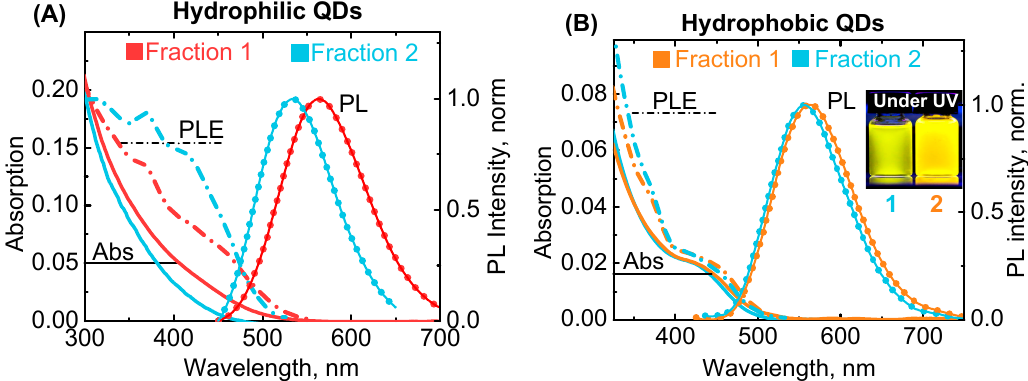
Figure 3. Photoluminescence and photoluminescence excitation spectra for two fractions of hydrophilic ( A ) and hydrophobic ( B ) AIS/ZnS QDs. PL excitation was done at 405 nm. PLE was registered at the maximum of PL (562 nm and 532 nm for Fraction 1 and Fraction 2 of hydrophilic QDs, respectively, and 560 and 550 nm for Fraction 1 and Fraction 2 of hydrophobic QDs, respectively). The images of hydrophobic QD solutions taken under a UV lamp are presented in the insert.